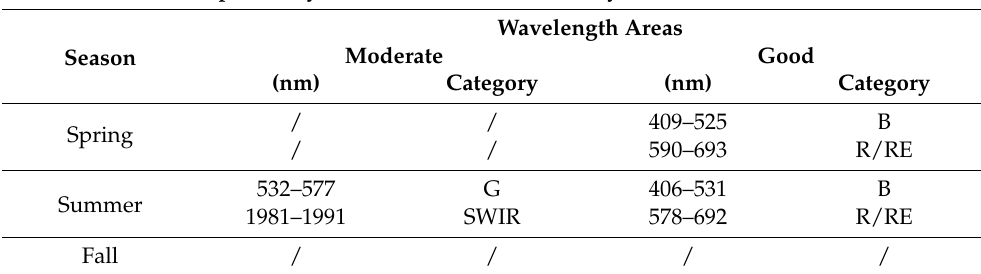
Table 2. Seasonal wavelength bands and spectral regions that offer moderate and good separation between western snowberry and wolfwillow based on thresholds established in Table 1 (B = Blue, R = Red, RE = Red-Edge, SWIR = Shortwave